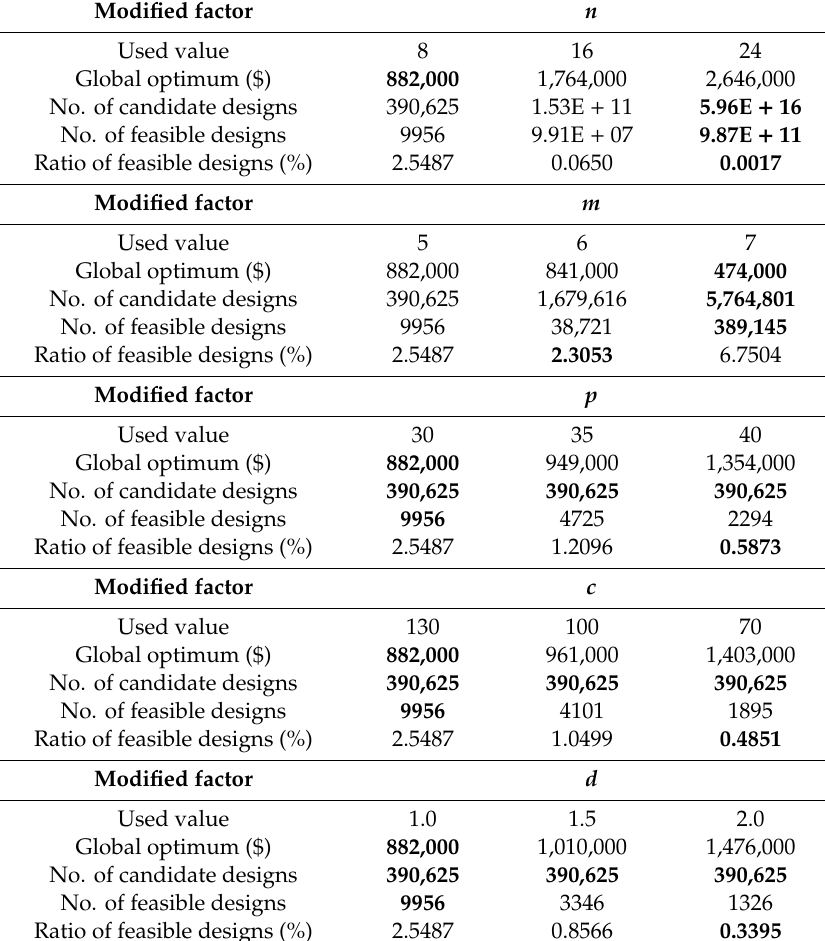
Table 3. Complete enumeration for the modified two-loop network design problems.